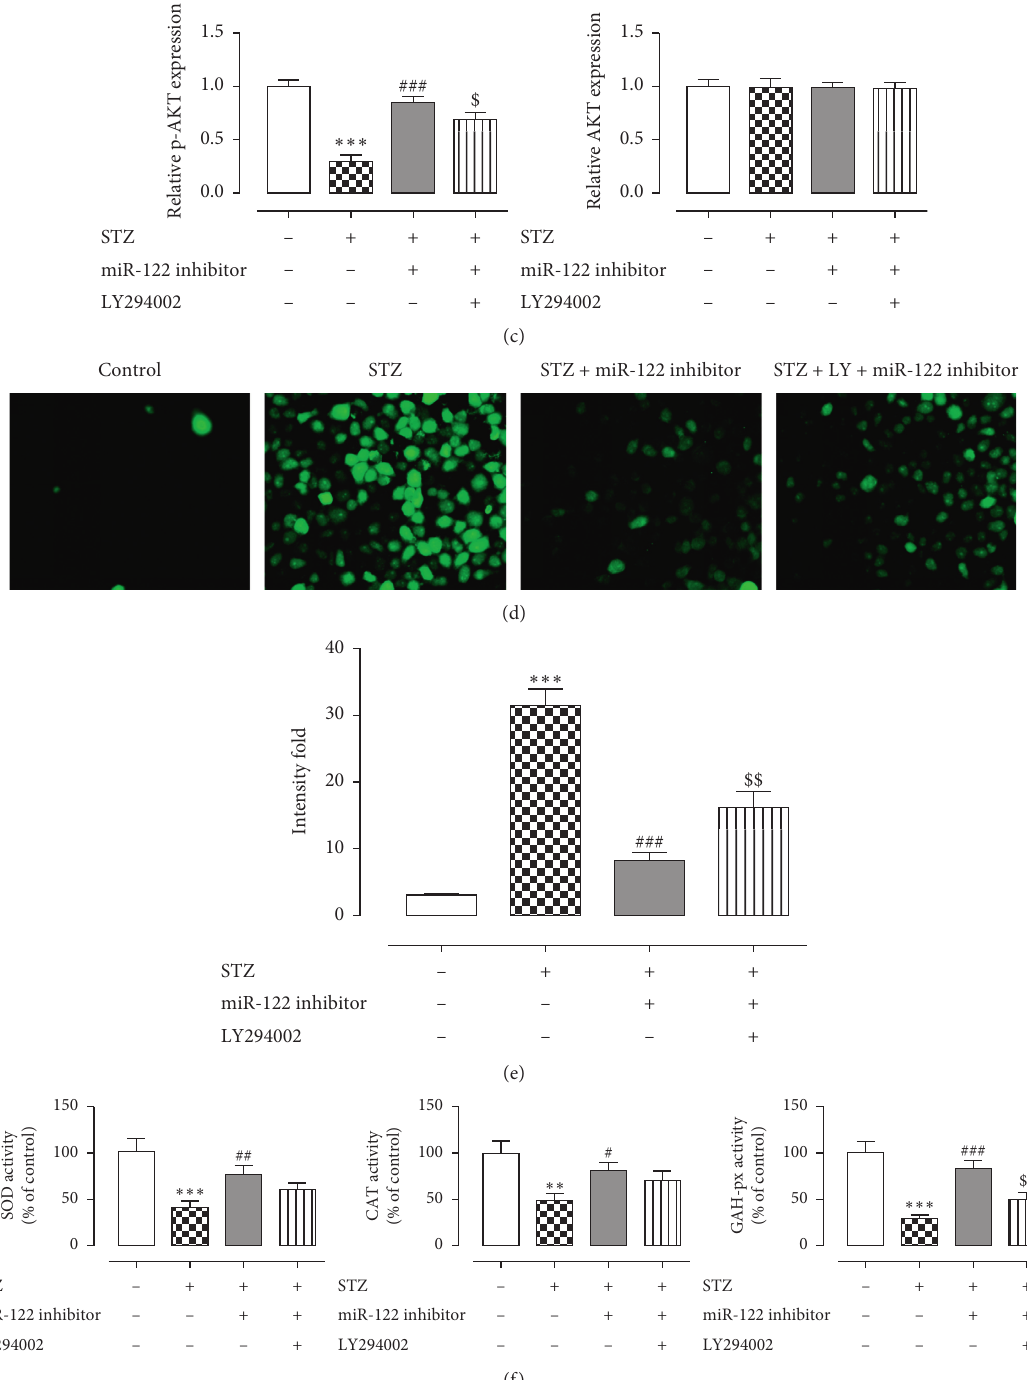
Figure 3: Detection of the oxidative stress levels after adding LY294002. (a-c) Detection of the expression levels of PI3K/AKT signaling pathway-related proteins after adding LY294002. (d, e) Detection of the intracellular ROS level. (f) Detection of the oxidative stress level in cells. ∗ P < 0 . 05, ∗∗ P < 0 . 01, ∗∗∗ P < 0 . 001 versus control group; # P < 0 . 05, ## P < 0 . 01, ### P < 0 . 001 versus STZ group. The experiment was repeated three